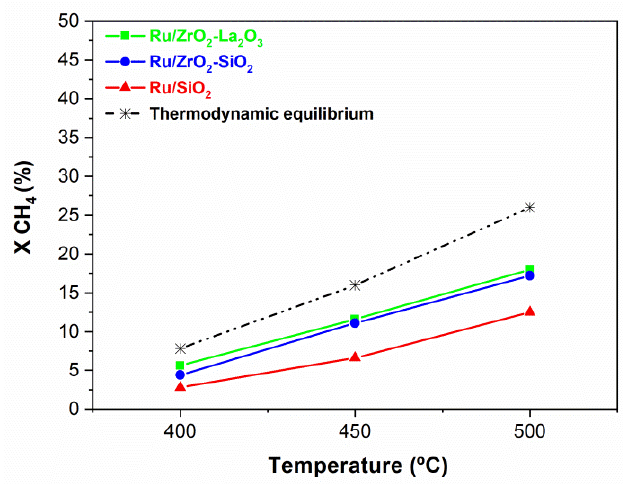
Figure 8. Methane conversion as a function of the temperature for the DRM reaction carried out in the CR over Ru/ZrO 2 -La 2 O 3 ( (cid:4) ), Ru/ZrO 2 -SiO 2 ( • ), and Ru/SiO 2 ( (cid:78) ); Feed composition: CH 4 : CO 2 ; He = 10:10:80; Total flow rate = 100 mL/min: P = 1 bar. Dotted line shows the thermodynamic equilibrium.